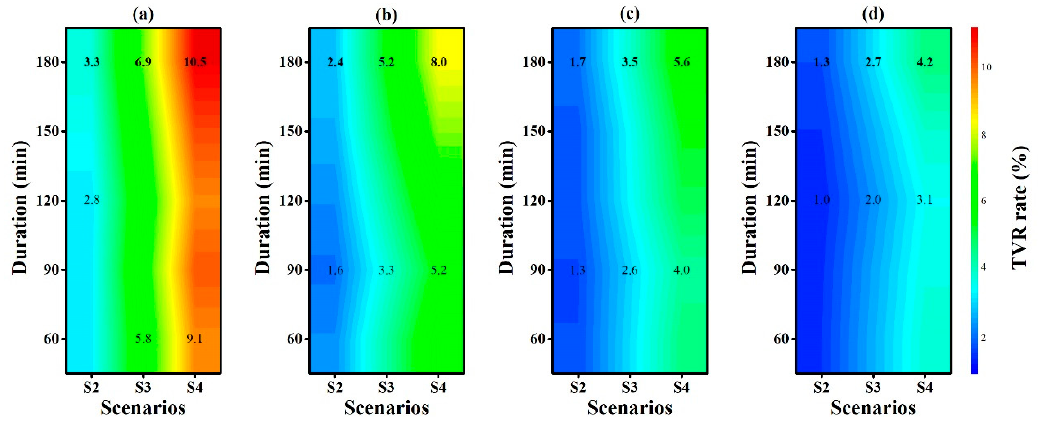
Figure 8. Total volume reduction (TVR) across three design scenarios (S2, S3, and S4) compared to current conditions (S1) during ( a ) 2-, ( b ) 5-, ( c ) 10-, and ( d ) 20-year rainstorm return periods (RP) of different durations.